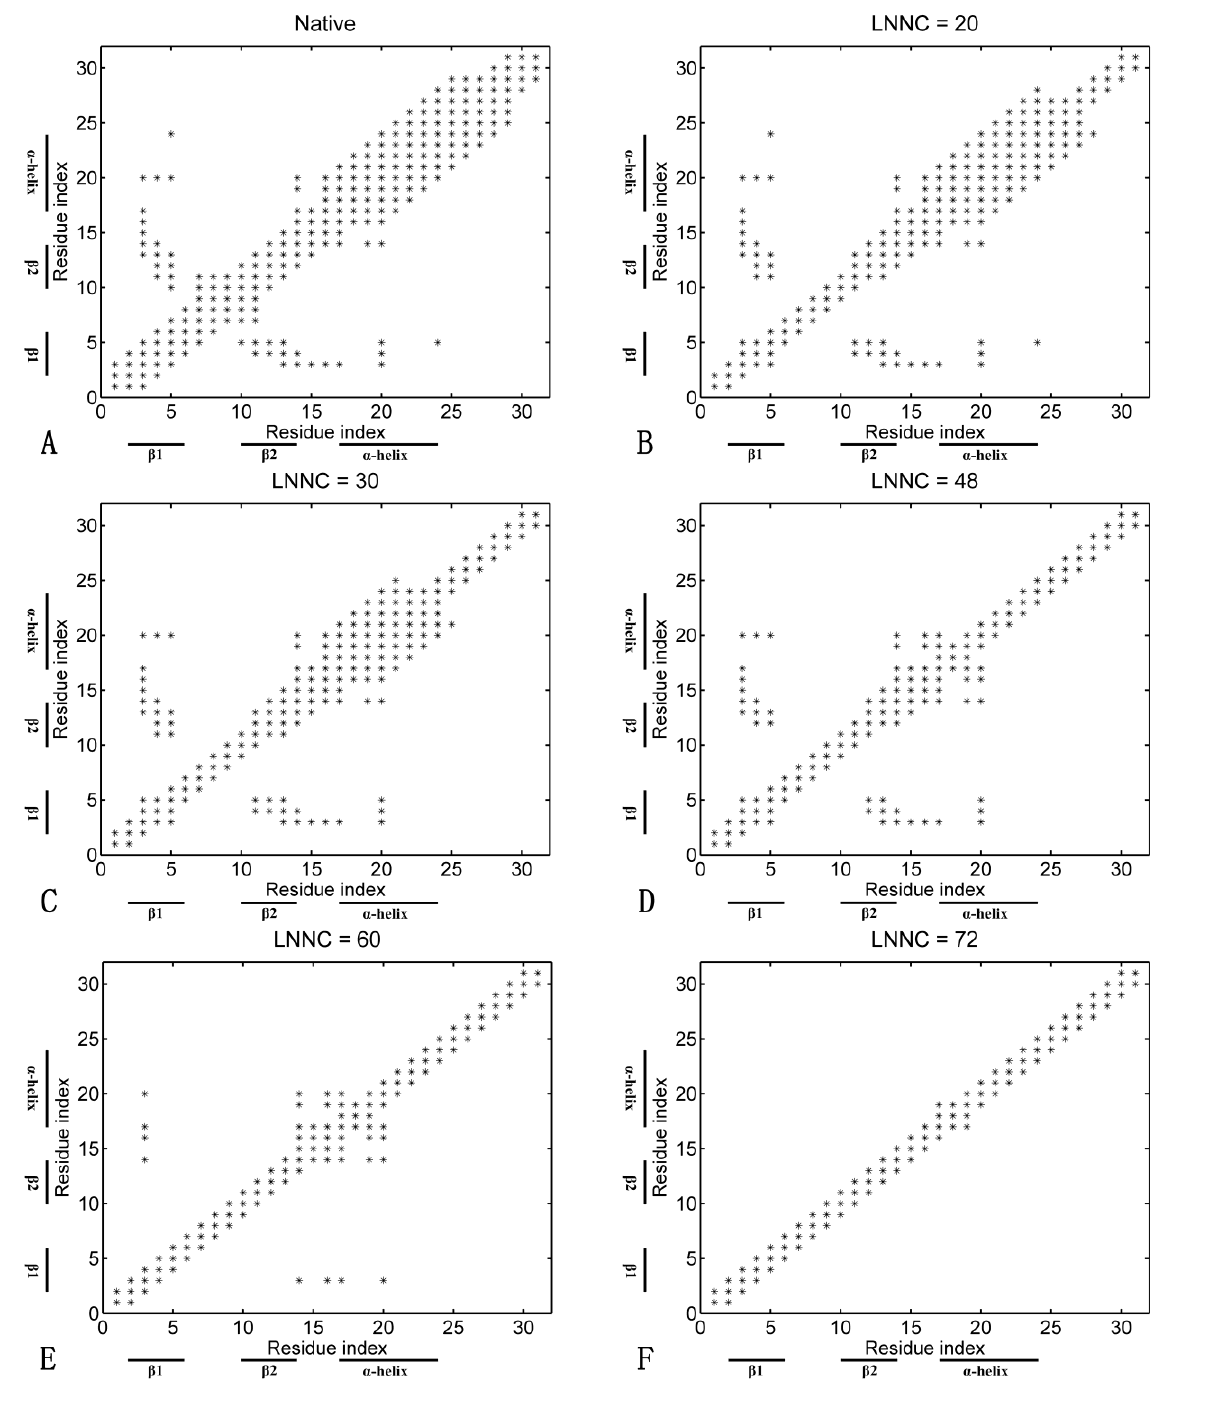
Figure 7. The contact maps of the native conformation ( A ), of the conformations with the LNNC to be 20 ( B ), 30 ( C ), 48 ( D ), 60 ( E ) and 72 ( F ) for Sp1f2 without zinc binding, respectively. Each native contact is marked by the symbol * in the